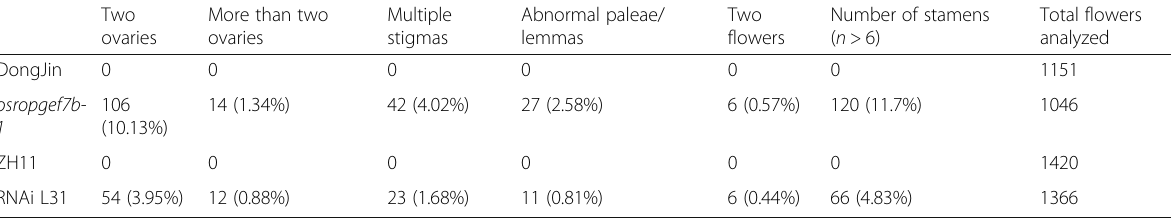
Table 1 Numbers of floral organs in wild-type and osropgef7b-1 plants Two ovaries